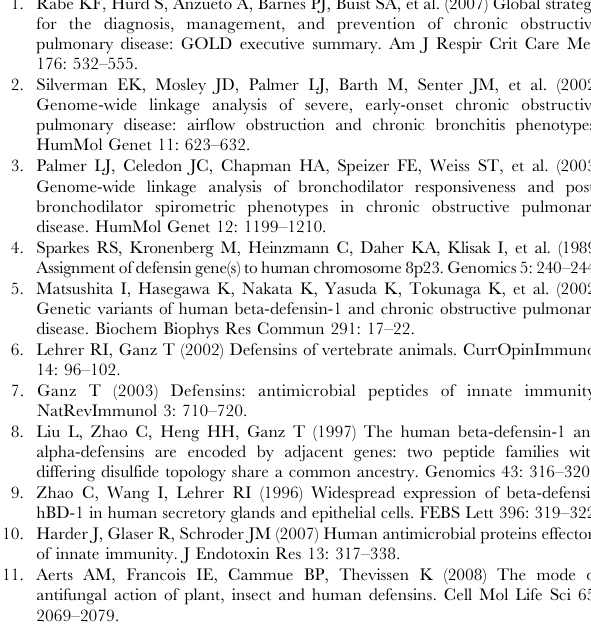
Comparison test. When the results were significant, the unpaired differences p , 0.05 considered significant. Results are presented as mean 6 SEM, each symbol represents a single sample. Figure S2 Histone deacetylase (HDAC) expression anal- ysis in bronchial epithelial cell biopsies. ( A ) Expression levels of HDAC1-11 mRNA in epithelial cell biopsies from COPD patients (N = 34) and healthy controls (N = 10). Levels of HDAC mRNA were quantified by Real-time PCR, variations of transcript levels were corrected by b 2 -M mRNA levels and log transformed for statistical analysis. Normal and non-normal distributed values were tested using unpaired t-test und Mann-Whitney test, respectively, with differences p , 0.05 considered significant. Results are presented as mean 6 SEM, each symbol represents a single sample. ( B ) Correlations between levels of HDAC1 mRNA and FEV 1 and the ratio FEV 1 /VC in epithelial cell biopsies from COPD patients (N = 34) and healthy controls (N = 10). Analysis was performed using Pearson correlation with differences p , 0.05 considered significant. Each symbol represents a single sample. Figure S3 Correlations between levels of HDACs und DEFB1 mRNA in bronchial epithelial cell biopsies.